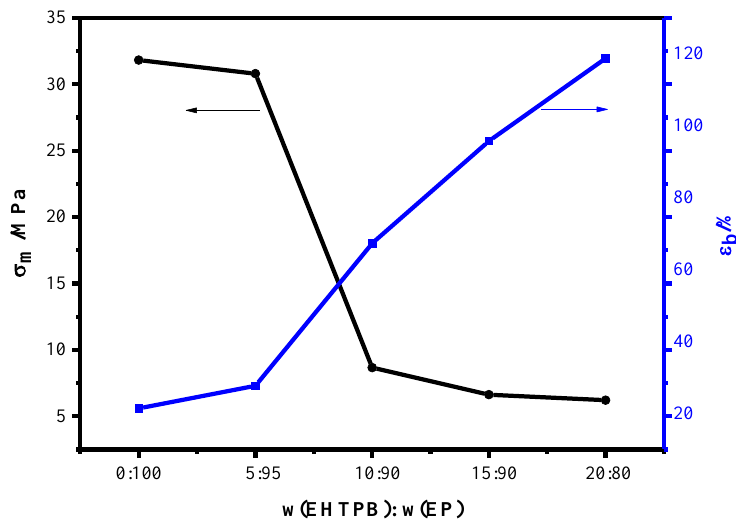
Figure 4. Mechanical properties of the modified epoxy resin with different w(EHTPB)/w(EP) ratios.